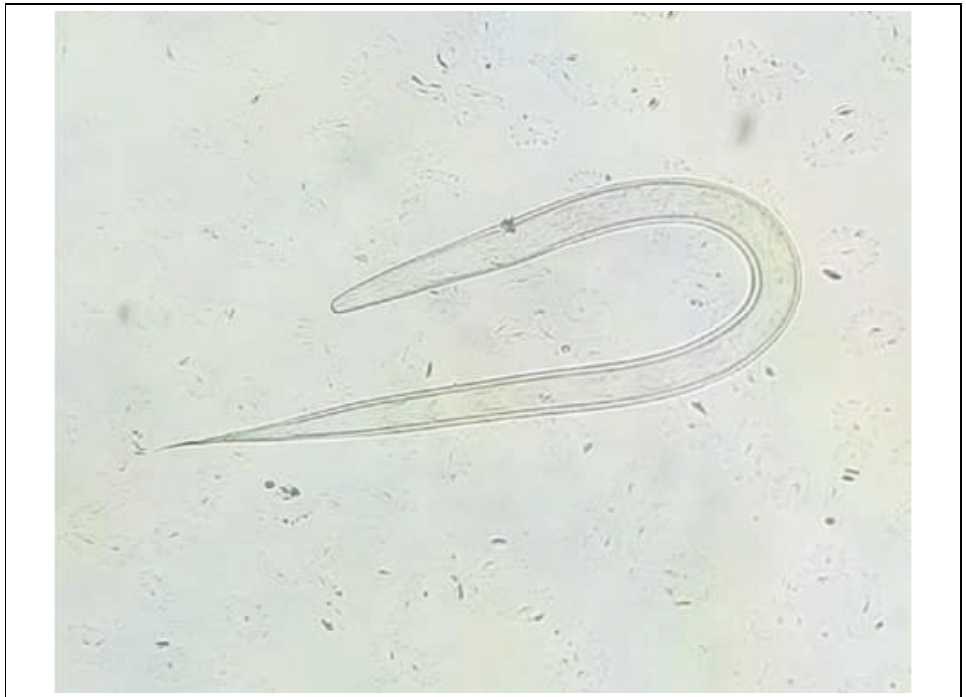
Fig 3. Haemonchus contortus larvae from pooled faecal culture Pooled faecal culture